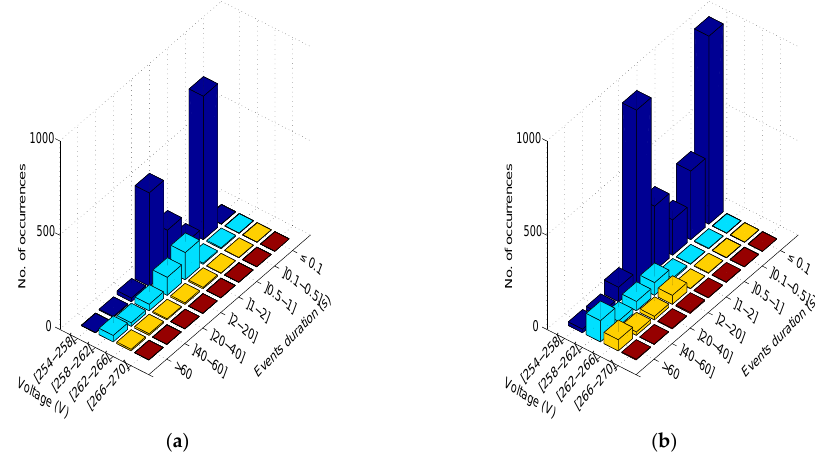
Figure 12. Statistical 3D voltage distributions for all recorded data: ( a ) swells before the grid strengthening; and ( b ) swells after the grid strengthening.